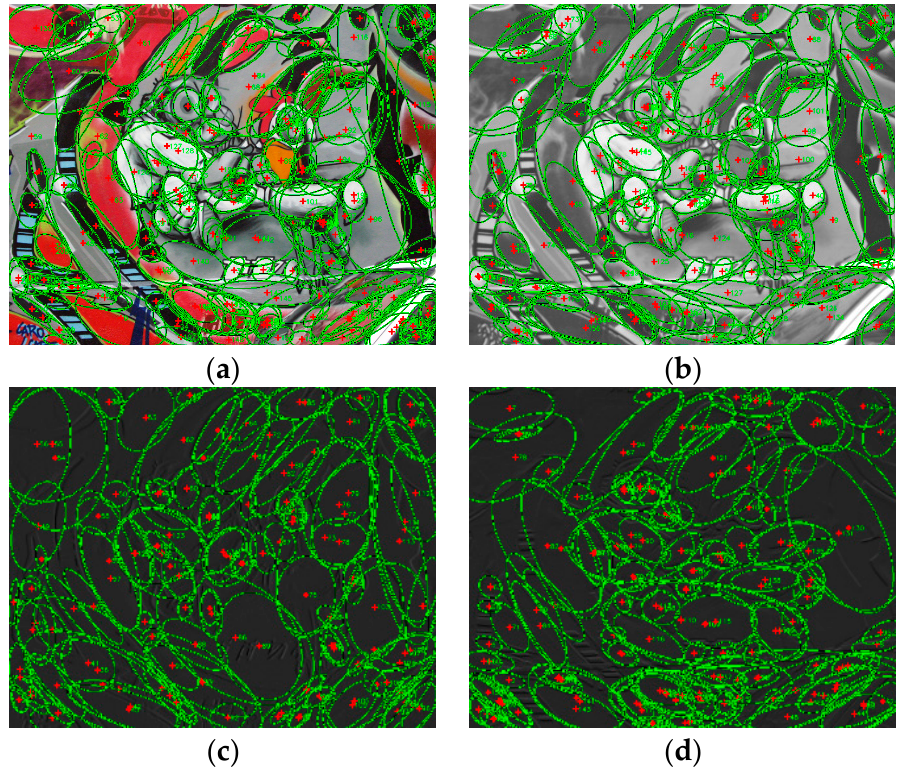
Figure 2. W α SH features on ( a ) original image, ( b ) LL layer, ( c ) LH layer, and ( d ) HL layer. According to the normalization theory in [16], the W α SH feature, an elliptical region, can be normalized into a circular one, on which the description of the feature is more robust to affine distortion. A variety of feature describing operators were compared in [27], reaching the conclusion that SIFT-based description operators have better robustness than others. Therefore, we use the SIFT algorithm to calculate the descriptors for W α SH